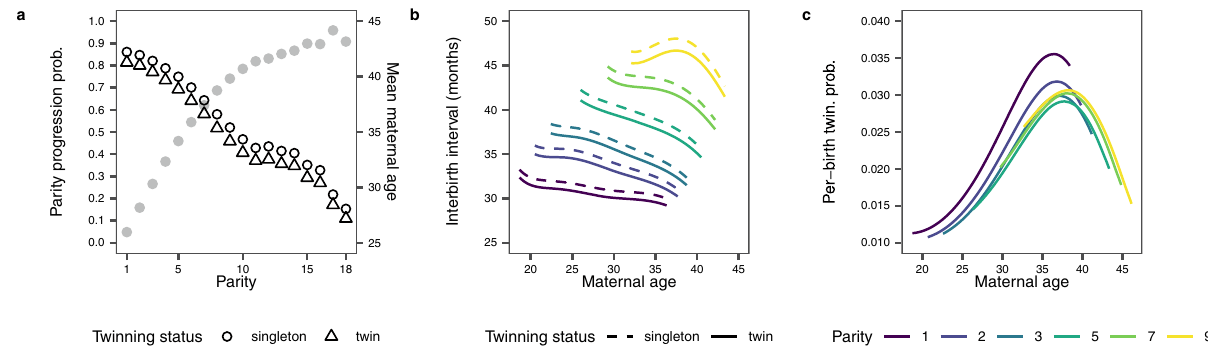
Fig. 4 Relationship between maternal age, parity and twinning status and the three life-history events describing maternal reproductive life. a The probability that a mother keeps reproducing after a given parity (parity progression) was lower following the birth of twins than following the birth of a singleton ( n = 105,833 births in total, from 21,290 mothers). Marginal predictions for the probability of parity progression are shown in black with open symbols, with scale on the left y -axis, and were computed given a parity and twinning status as average predictions over the empirical distribution of maternal age at each parity. The mean of maternal age for each parity is shown by the grey line with fi lled symbols, with the scale on the right y -axis. b The duration between two consecutive births (interbirth interval) increased with parity (colour) but slightly decreased after the birth of twins vs singleton (line type) or with maternal age ( x -axis) when parity is held constant ( n = 84,543 births in total, from the 18,520 mothers who had at least two births). c Mothers presented the highest risk of twinning ( n = 105,833 births in total, from 21,290 mothers) during their mid and late thirties, as well as at parity 1 (purple line). For ( b , c ), marginal predictions are shown as curves and are computed for maternal age and parity values spanning the 95% central ranges of the observed distributions of these variables. Model summary statistics are provided in Supplementary Tables 4 –